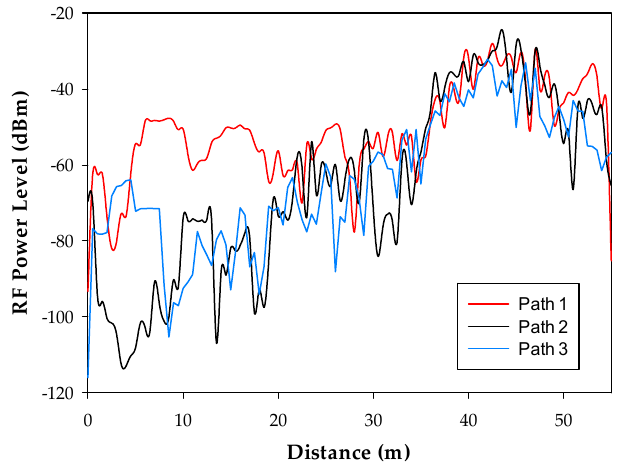
Figure 12. Three paths for linear RF power level distribution. The results correspond to the white dashed lines in Figure 11.